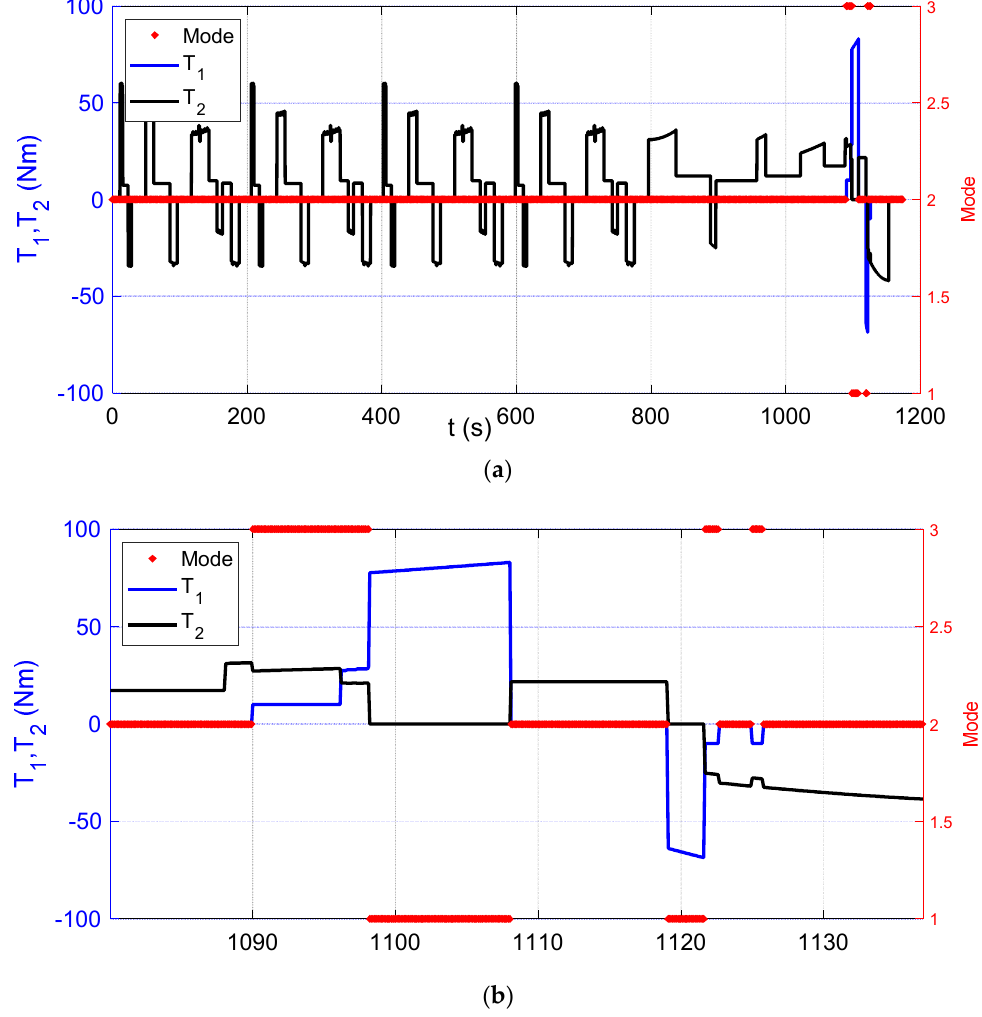
Figure 4. ( a ) Torque distribution and driving modes under NEDC driving cycle. ( b ) Torque distribution and driving modes under NEDC driving cycle (amplified).